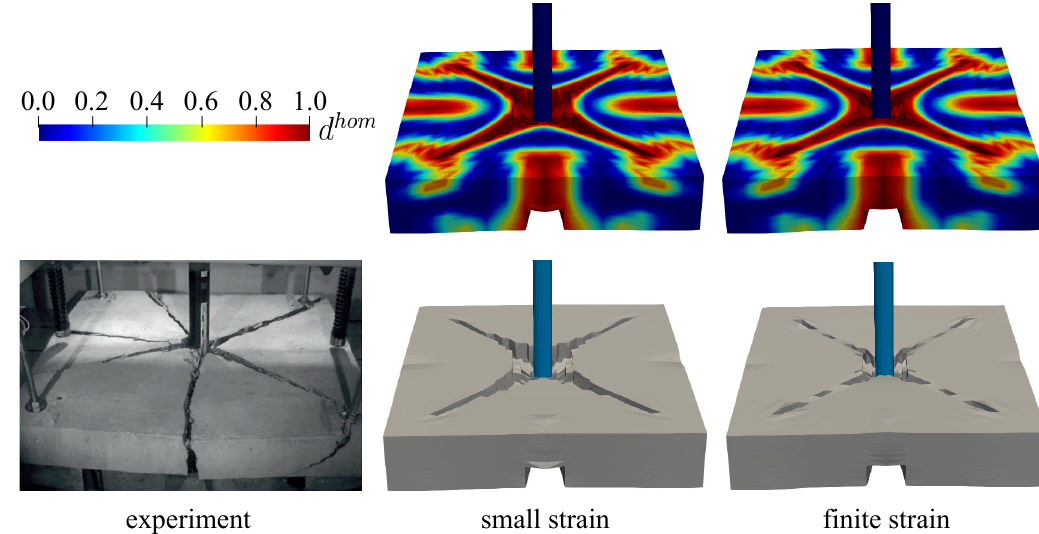
Figure 19. Comparison of damaged plate reported in [47] to both small and finite strain models.